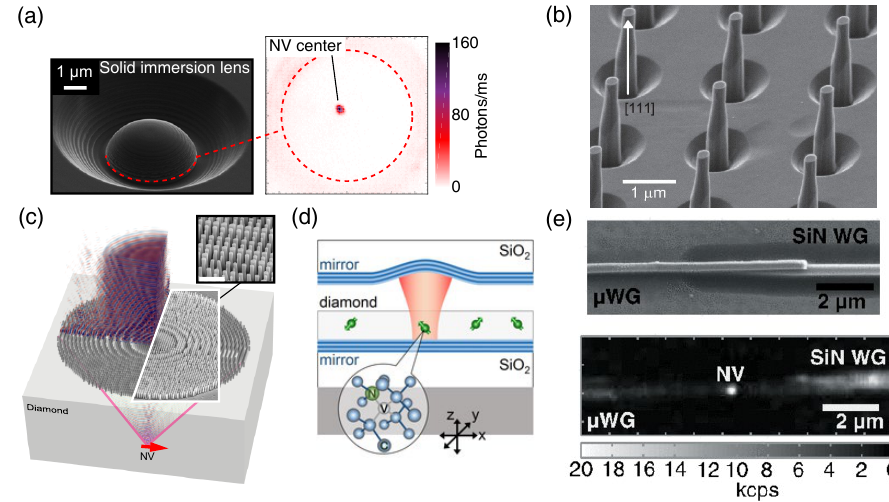
Figure 2. Photonic devices for improving collection efficiency ( a ) Scanning electron micrograph (SEM) of a solid immersion lens fabricated around an NV center. Inset: confocal PL image. ( b ) Diamond nanopillar array fabricated on a [111]-oriented diamond. Source: Neu et al. [58]. ( c ) Metalens fabricated above an NV center to act as an immersion objective. Inset: SEM of nanopillar metalens elements. Source: Grote et al. [57]. ( d ) Schematic of diamond membrane embedded in an open micro-cavity. Source: Riedel et al. [59]. ( e ) SEM of a hybrid diamond/silicon-nitride waveguide and a PL map of an NV center within the diamond waveguide. Source: Mouradian et al.